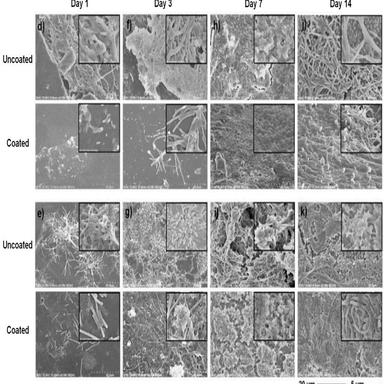
Method and results of animal study. a) Dental casts of maxillary and mandibular arches (top), and Fabrication of VFCs (bottom). b) Delivery of VFCs (additional resin bonding and orthodontic miniscrew installation was performed for retention). c) Removal of VFCs on day 14. Representative images of canine oral bacterial biofilms formed on outer (d, f, h, j) and inner (e, g, i, k) surfaces of the specimens after animal experiment. The oral biofilms were established for 1, 3, 7 and 14 days. Two images (uncoated